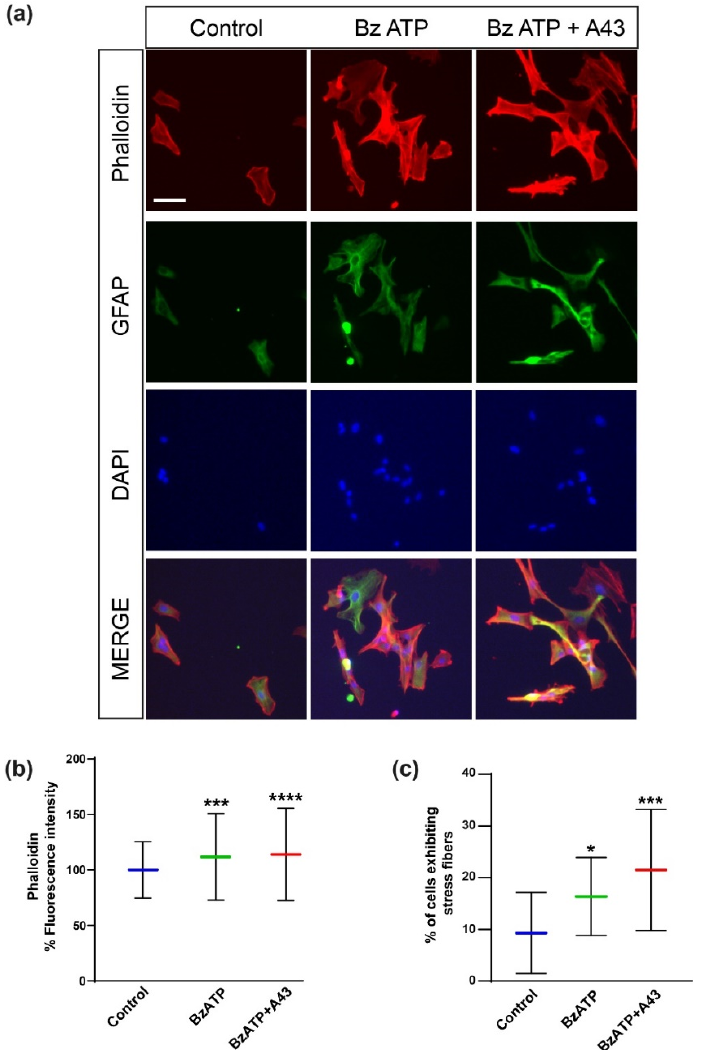
Figure 8. P2X7 receptor stimulation induced reorganization of cytoskeleton proteins in rat cerebellar astrocytes. ( a ) Fluorescence images of astrocytes labelled with rhodamine-conjugated phalloidin (red) and immunostained with anti-GFAP antibodies marked with Alexa Fluor 488 (green) secondary antibodies, after time-lapse recording. Statistics show the distribution of the fluorescence intensity of phalloidin staining ( b ) and number of cells exhibiting stress fibers ( c ). Whiskers indicate SD. Statistically significant differences were calculated by employing a one-way ANOVA with Dunnett’s post-test and are indicated by * when p < 0.05, *** when p < 0.001, and **** when p <